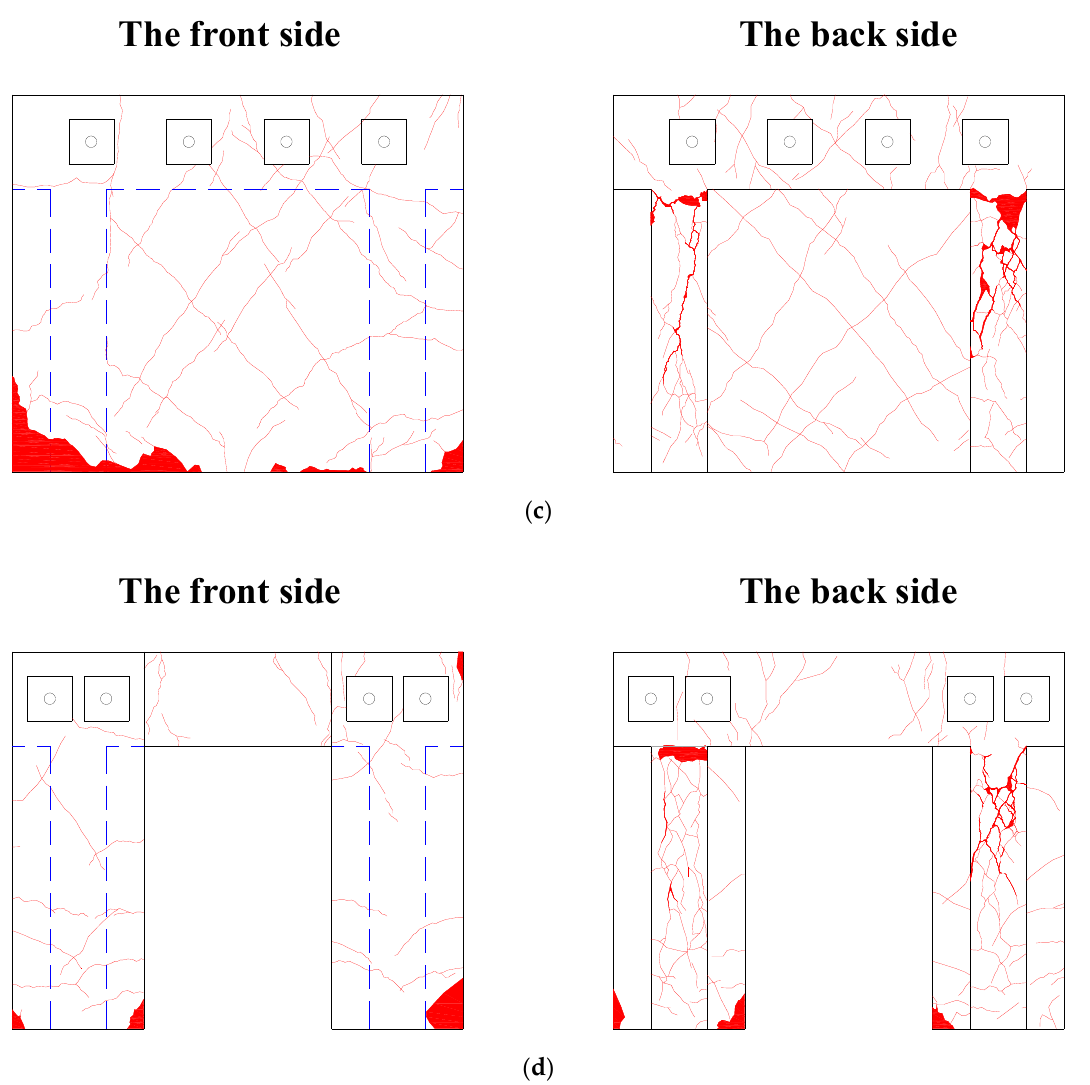
Figure 7. Observed crack patterns of specimens after failure: ( a ) Specimen FC; ( b ) Specimen FBC; ( c ) Specimen FB; ( d ) Specimen FPB.